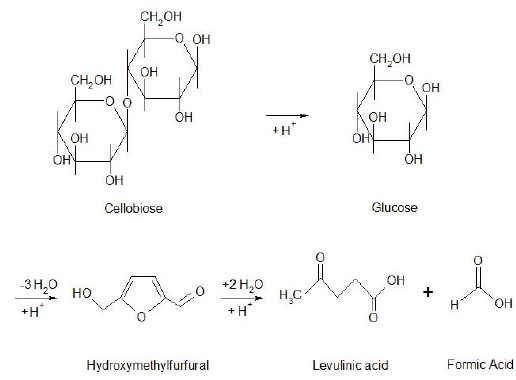
Figure 1. Formation of selected fermentation inhibitors from glucose during acid hydrolysis.